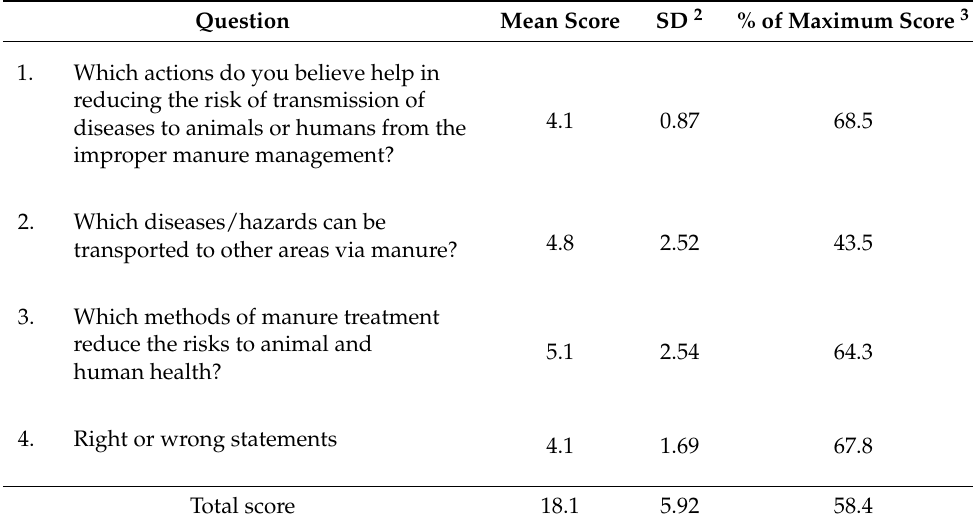
Table 3. Participants’ knowledge concerning safe manure management 1 .